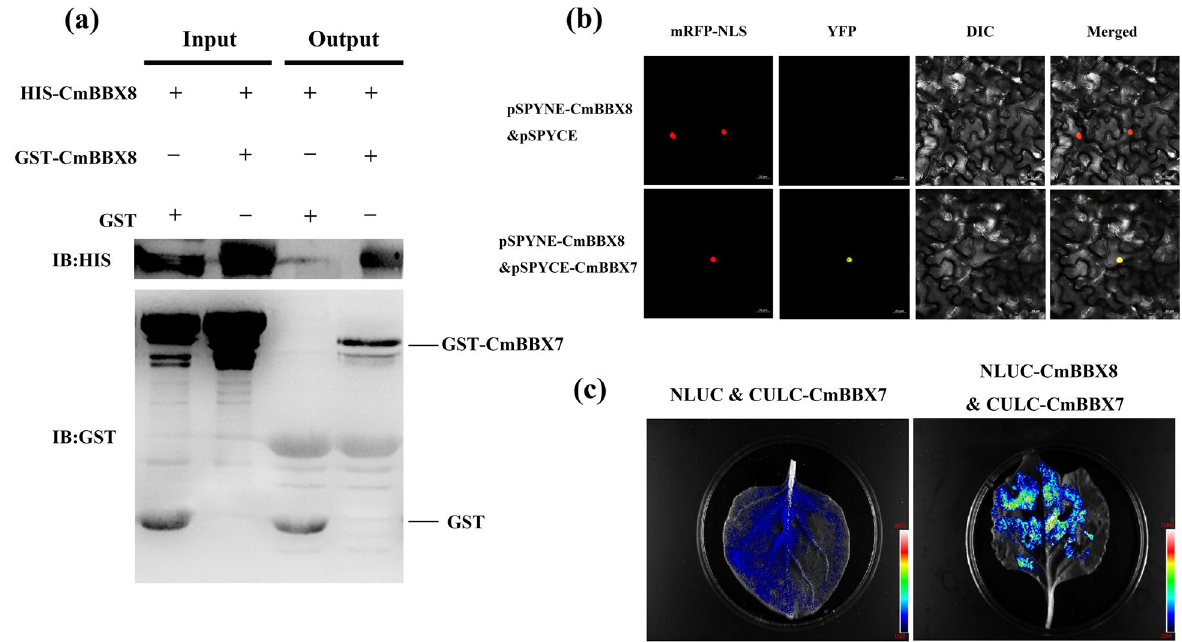
Fig. 5 CmBBX7 interacts with CmBBX8. a Pull-down assays of the interaction between CmBBX7 and CmBBX8. The arrows show the target protein sizes. GST-empty vector and His-CmBBX8 were used as controls. b BiFC assay. mRFP-NLS: images taken in the red fluorescence channel; YFP: images taken in the yellow fluorescence channel; DIC: images taken in bright light; Merged: both overlay plots; bars complementation imaging (LCI) assay verified the interaction between CmBBX7 and CmBBX8 in N. benthamiana